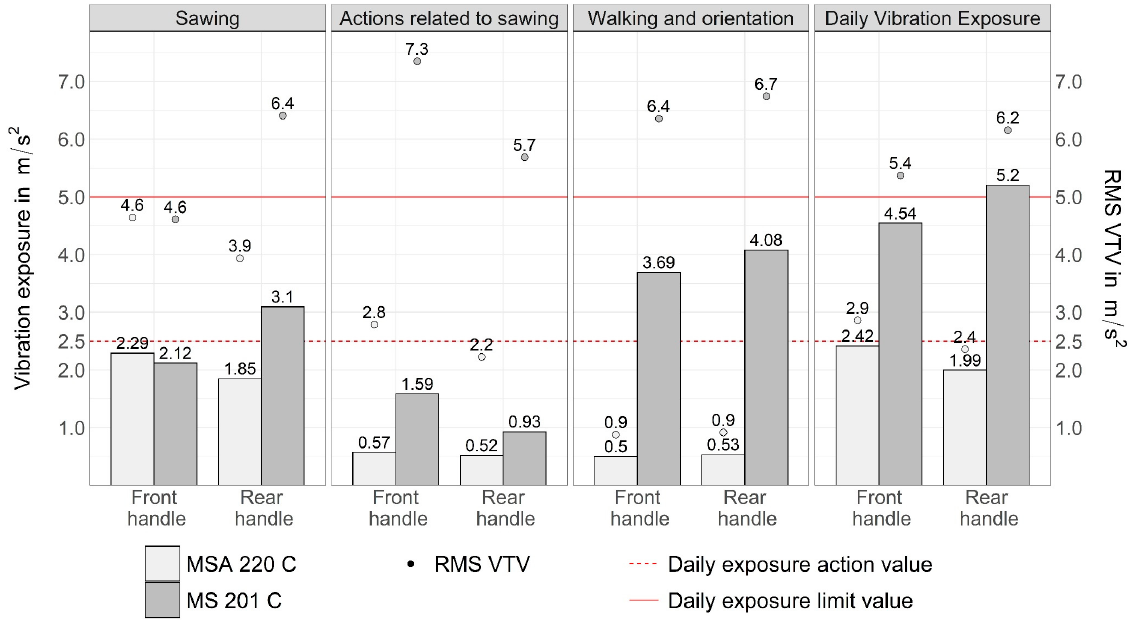
Figure 3. Partial daily vibration exposures of the different work elements and the resulting daily vibration exposure. The dots mark the respective RMS VTV.